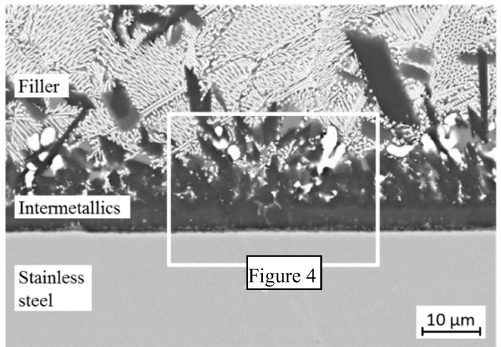
Figure 3. Microstructure (SEM) of braze filler B-Al40Ag40Cu20 wetted on stainless steel AISI 304L, braze current intensity 40 A [29].